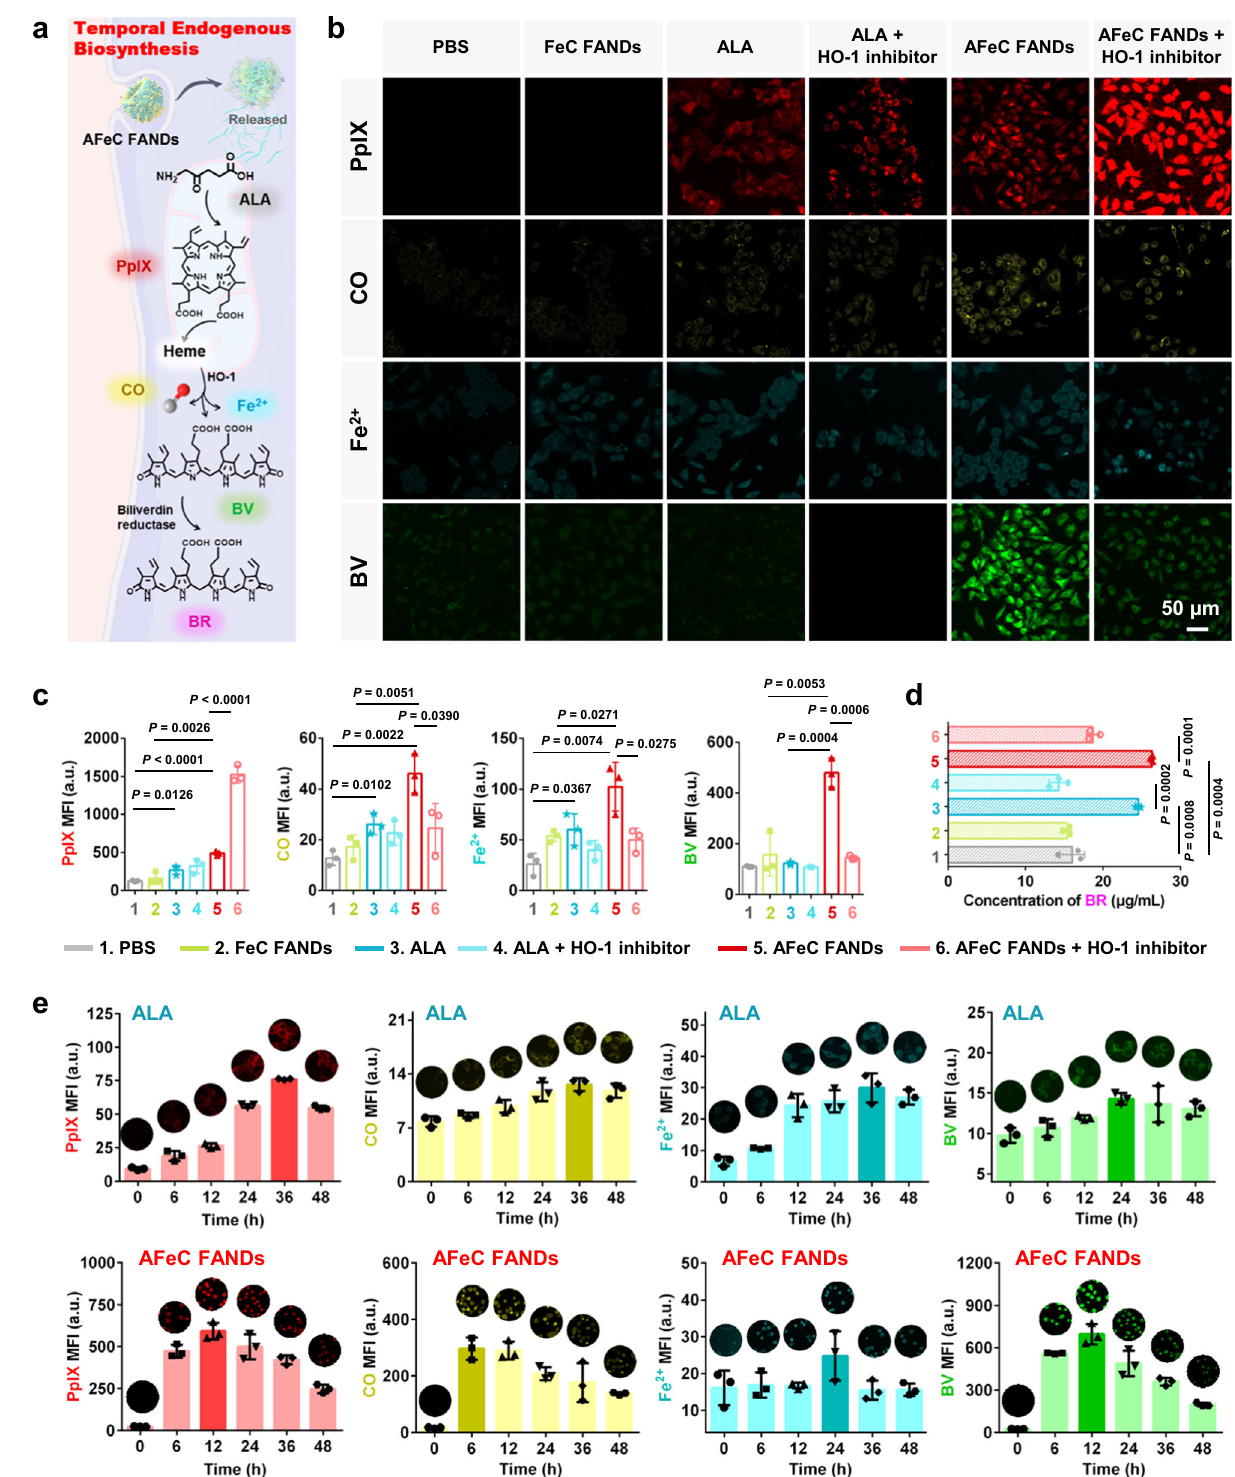
Fig. 4 | Temporal endogenous biosynthesis of a series of therapeutic metabo- lites basedonALA-PpIX-heme-CO/Fe 2+ /BV-BR metabolism.a Simpli fi edscheme of the tandem metabolism pathwayof5-aminolevulinic acid(ALA). b Fluorescence images and c the corresponding mean fl uorescenceintensity (MFI) quanti fi cations of PpIX, CO, Fe 2+ , and biliverdin (BV) in A549 cells with various treatments. d Cellularquantitative analysisof endogenousbilirubin (BR)indifferentgroupsby